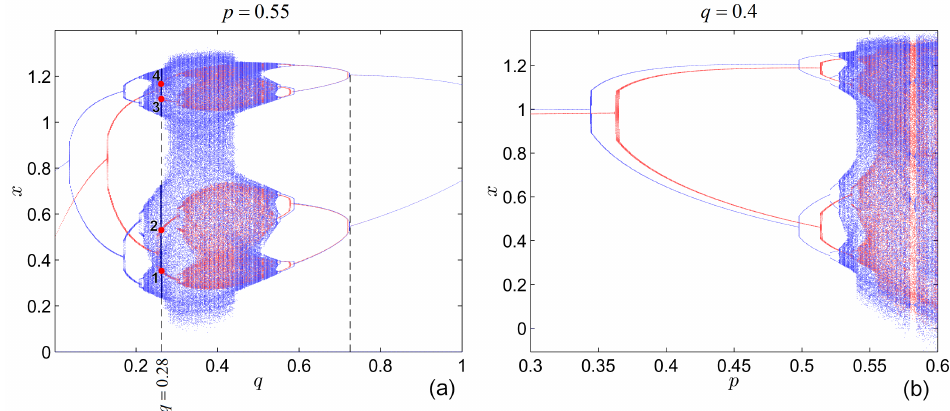
Figure 3. ( a ) The BD for p = 0.55 vs. q with two BSs: one obtained for ( x 0 , y 0 ) = ( 0.1,0.3 ) , in Figure 2a (red plot), and one for a second initial condition ( x 0 , y 0 ) = ( 0.5,0.5 ) (blue plot); ( b ) the BD for q = 0.4 vs. p ∈ ( 0.3,0.6 ) with two BSs: one for ( x 0 , y 0 ) = ( 0.1,0.3 ) , in Figure 2b (red plot), and a new one for ( x 0 , y 0 ) = ( 0.9,0.6 ) (blue plot). Dotted line in the BD in Figure 2b indicates the existence of two different attractors: a four-periodic-like orbit (red bullets) and a two-period chaotic band orbit (dark blue segments).